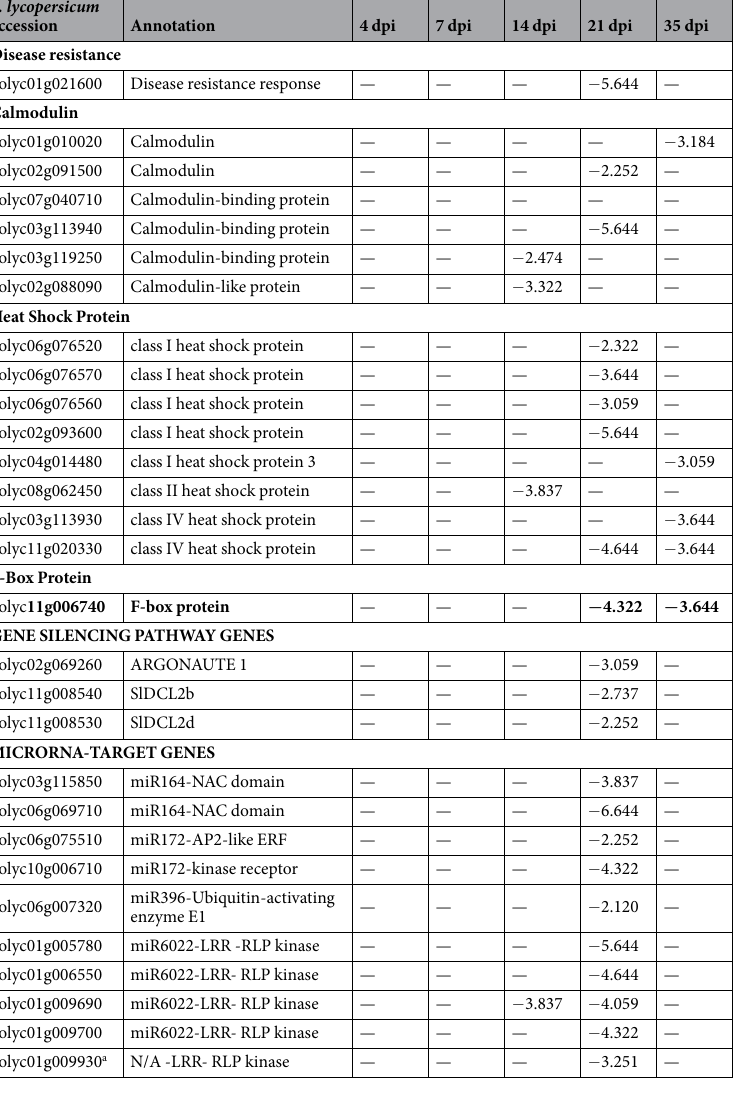
Table 1. Selected differentially expressed defense-related, RNA silencing pathway and microRNA target genes in Sw-7 compared to the S-line after TSWV inoculation. a N/A referred to be a non-annotated microRNA (It is not registered at the miRBase registry; it can be considered as a new